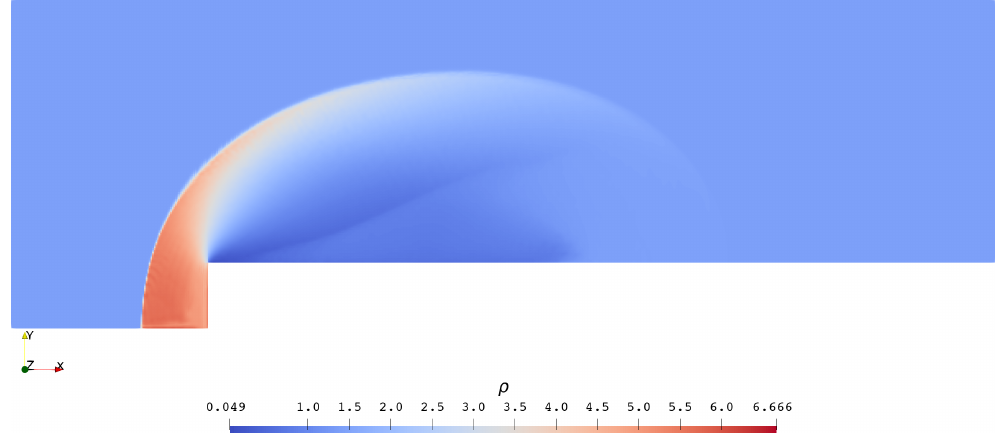
Figure 10. Third-order solution of Problem 4 at t = 0.4 on an h = 1/200 mesh.